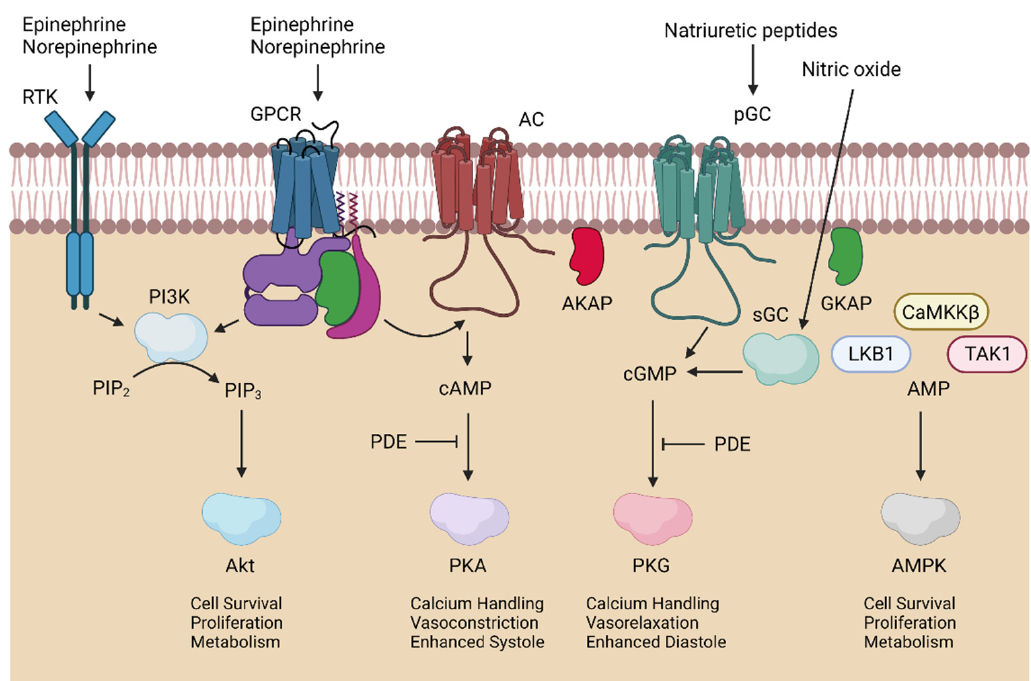
Figure 1. Summary of Cardioprotective Kinase Signaling Pathways. From left to right, receptor tyrosine kinases (RTK) or G-protein coupled receptors (GPCR) stimulate phosphoinositide 3-kinase (PI3K) to produce phosphatidylinositol-(3,4,5) triphosphate (PIP 3 ) from phosphatidylinositol-(4,5) bisphosphate (PIP 2 ) and leads to protein kinase B (Akt) activation. Protein kinase A (PKA) activity is induced by GPCR-mediated adenylyl cyclase (AC) stimulation, which produced cyclic adenosine monophosphate (cAMP), regulated by A-kinase-anchoring proteins (AKAP) and phosphodiesterases (PDE). Natriuretic peptides and nitric oxide, respectively, trigger particular and soluble guanylyl cyclase (pGC/sGC) to make cyclic guanosine monophosphate (cGMP), also regulated by PDE and G-kinase-anchoring proteins (GKAP), and initiate protein kinase G (PKG) activity. Finally, AMP kinase (AMPK) is activated by AMP, along with the following kinases: liver kinase B1 (LKB1), calmodulin-dependent protein kinase kinase β (CaMKK β ), and transformation growth factor- β -activated kinase-1 (TAK1).